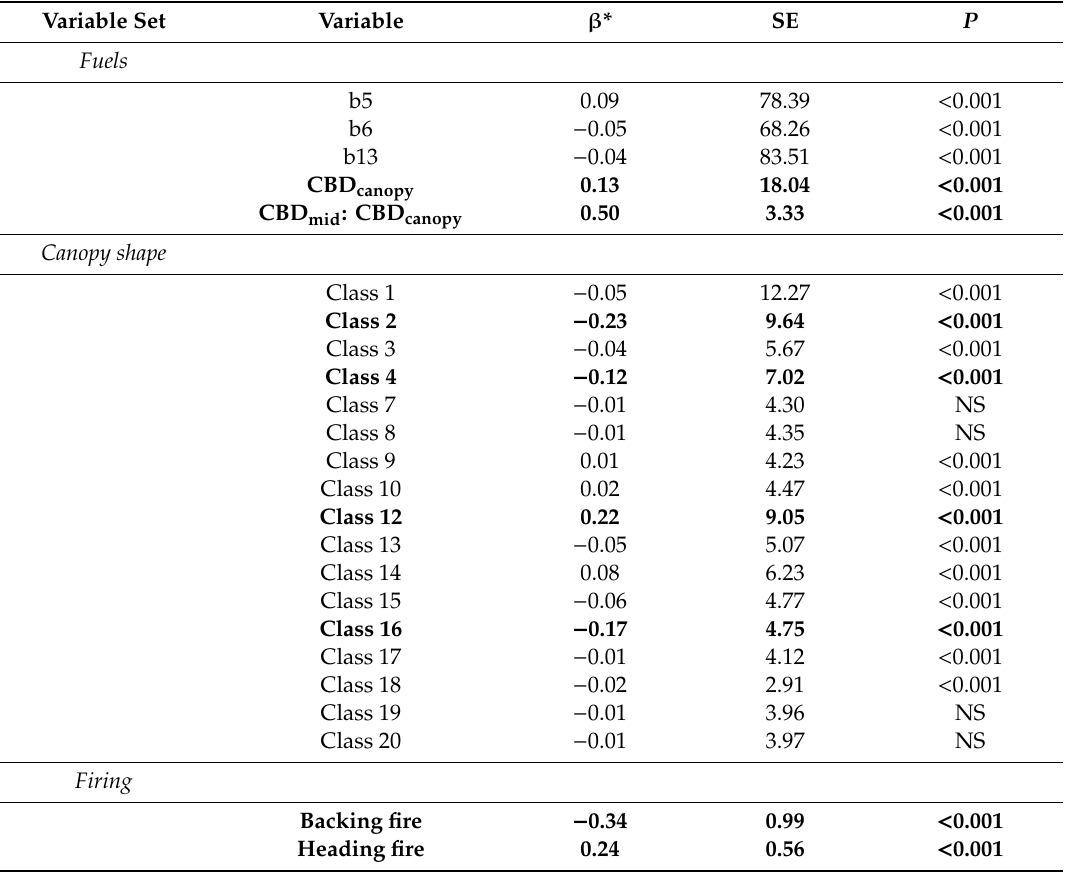
Table 4. Ordinary least square statistics from the Fuels + Shape + Firing model. Variables with standardized coe ffi cients of more than 0.1 are shown in